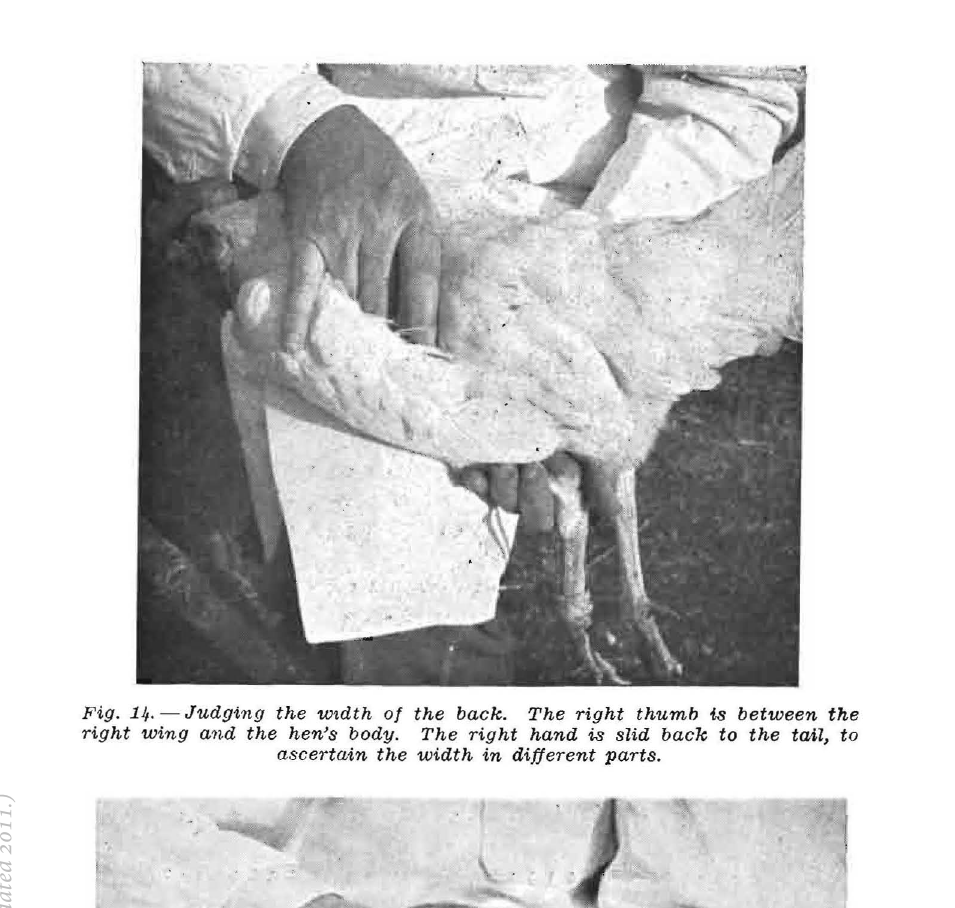
Fig. 15. -Measuring the depth of the body. The right thumb is slid along the centre of the back and the second finger along the keel. The body of a good layer must be broad and